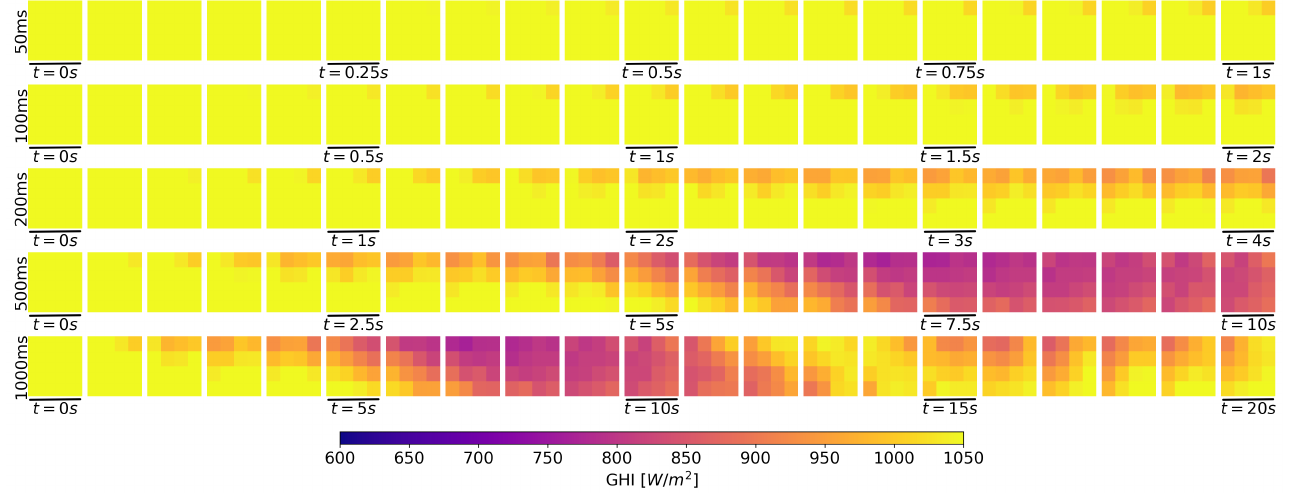
Figure 13. Snapshots evolution from data represented in Figure 12. Each row represents the evolution at different sampling